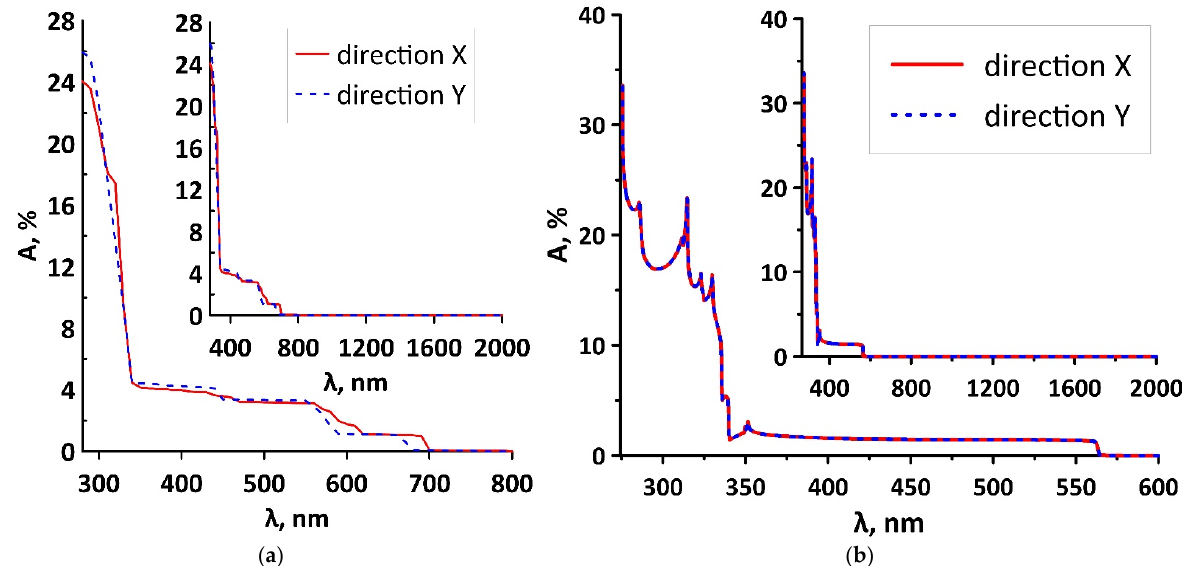
Figure 6. The absorbance spectra of van der Waals ZnO/BlueP/ZnO heterostructure with AAA stacking configuration ( a ) and BlueP monolayer ( b ) for two cases of electromagnetic wave polarization (along the X and Y axes).